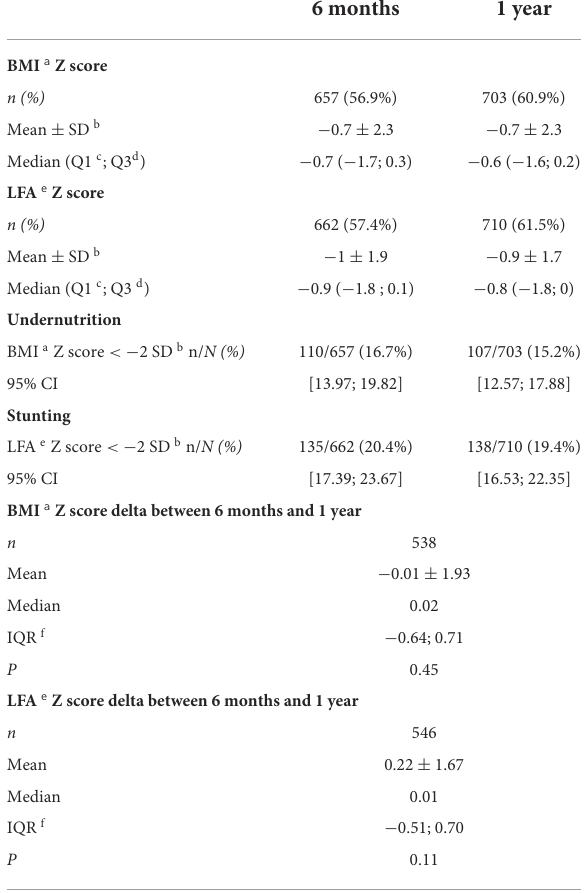
TABLE 2 Anthropometrics at ages 6 months and 1